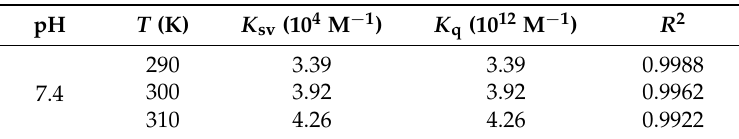
Figure 3. Fluorescence changes in HSA upon addition of Dp44mT and Stern-Volmer plot (pH 7.4, 298 K). ( a ) The fluorescence intensity deceased with increasing amounts of Dp44mT; and ( b ) Stern-Volmer plots for quenching of HSA fluorescence by Dp44mT at different temperatures. Down arrow: trend of fluorescence decreased. Table 1. The Stern-Volmer quenching constant K sv and bimolecular quenching rate constant K q of the HSA-Dp44mT system at different temperatures were deduced from Figure 3b as described [16]. λ ex = 295 nm, λ em = 290–500 nm.